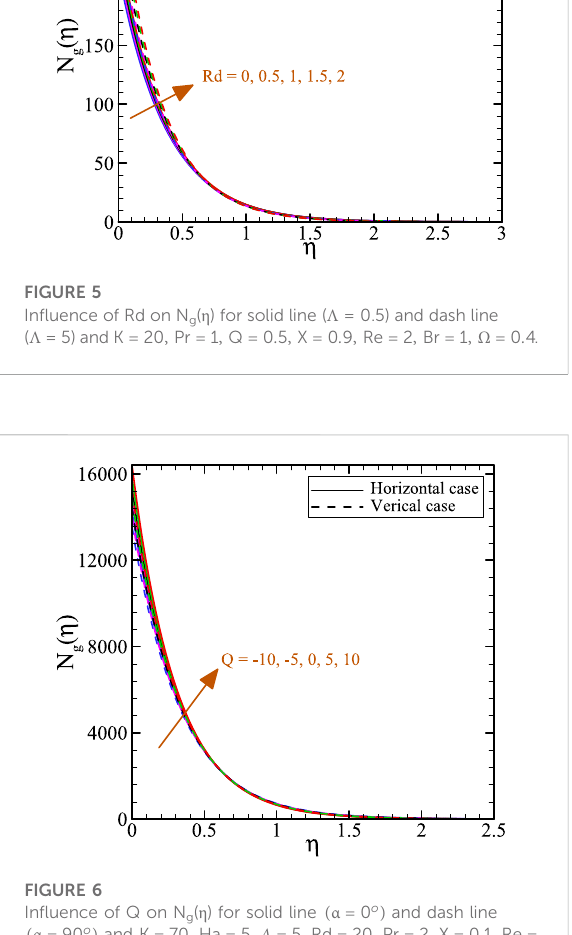
FIGURE 4 In fl uence of Γ on N g ( η ) for solid line (Rd = 3) and dash line (Rd = 20) K (cid:3) 80 , Pr (cid:3) 1 . 5 , Q (cid:3) 5 , X (cid:3) 0 . 6 , Re (cid:3) 4 , Br (cid:3) 2 , Ω (cid:3) 0 . 5.